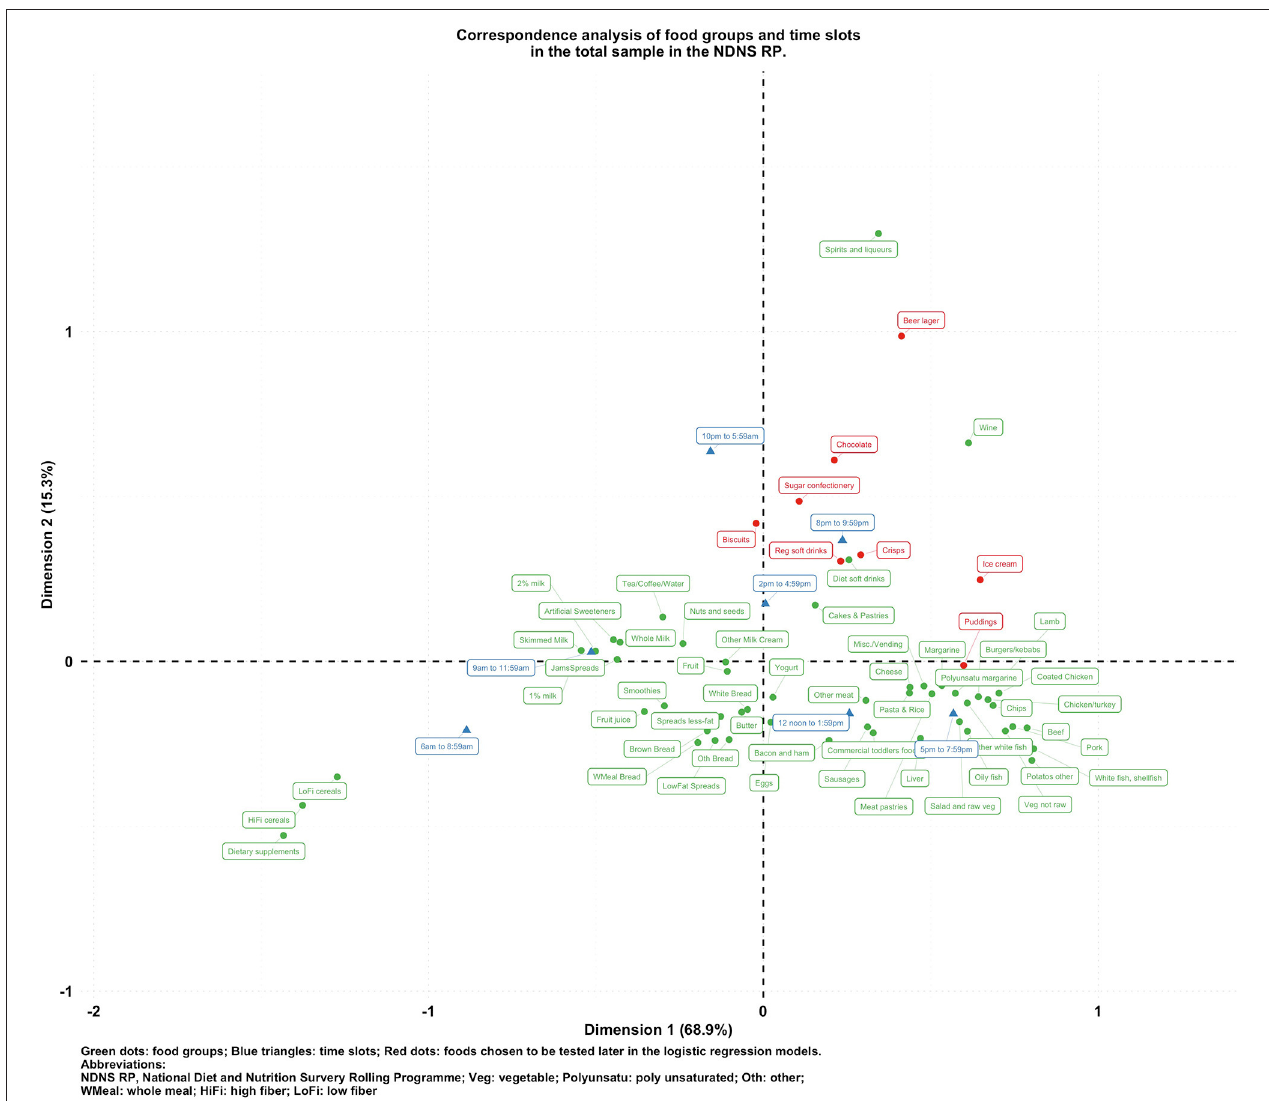
FIGURE 1 | Biplot of food groups and eating time slots in the total sample in the NDNS